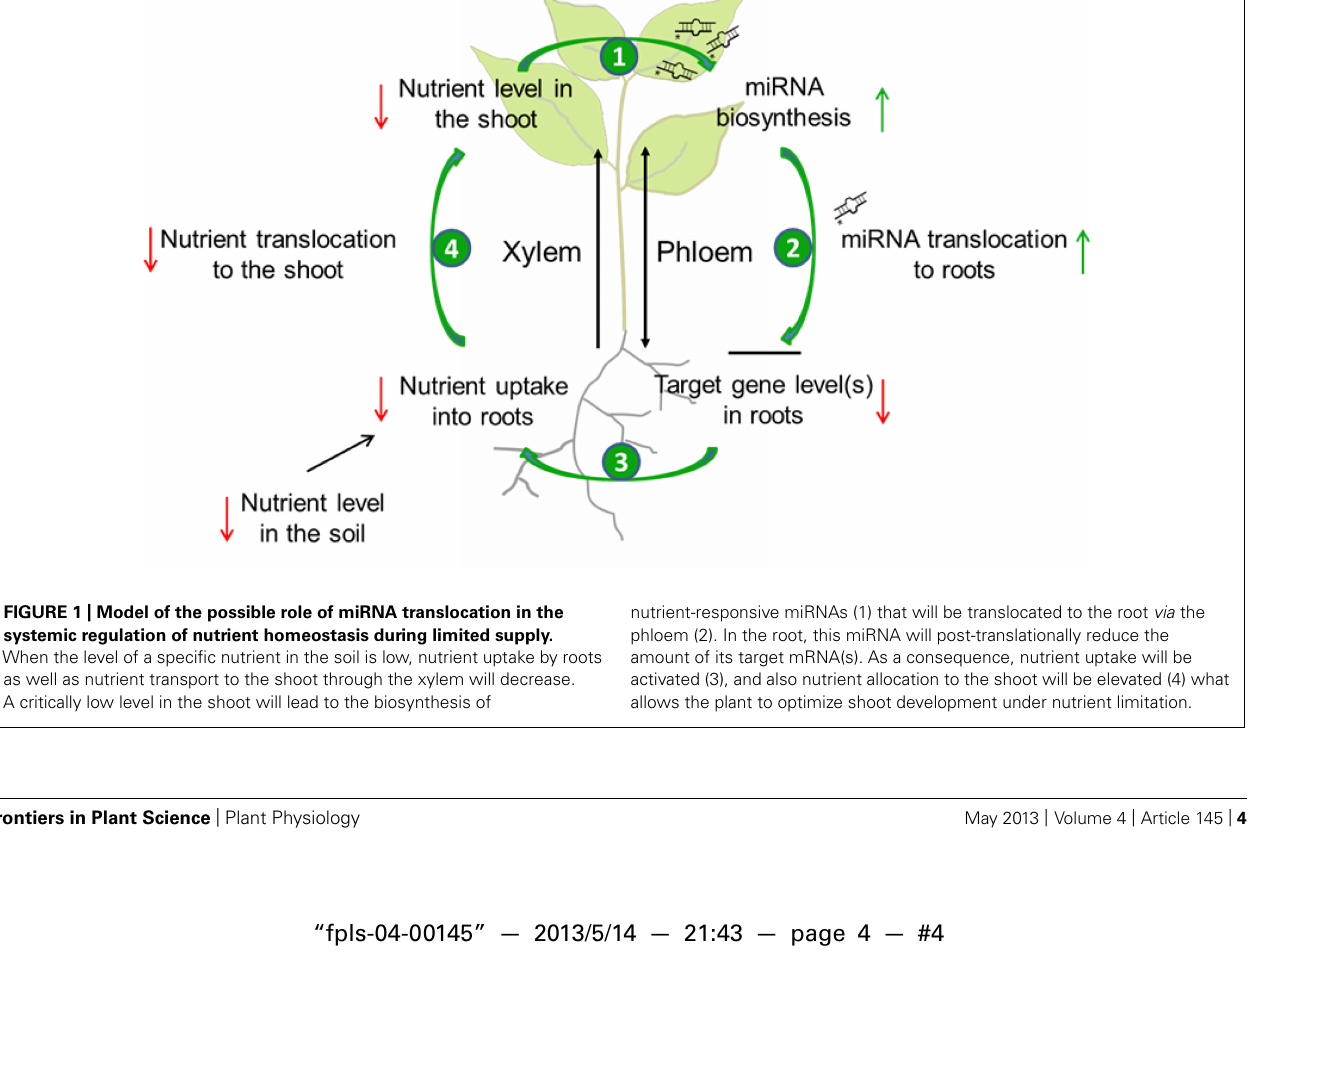
FIGURE 1 | Model of the possible role of miRNA translocation in the systemic regulation of nutrient homeostasis during limited supply. When the level of a specific nutrient in the soil is low, nutrient uptake by roots as well as nutrient transport to the shoot through the xylem will decrease. A critically low level in the shoot will lead to the biosynthesis of